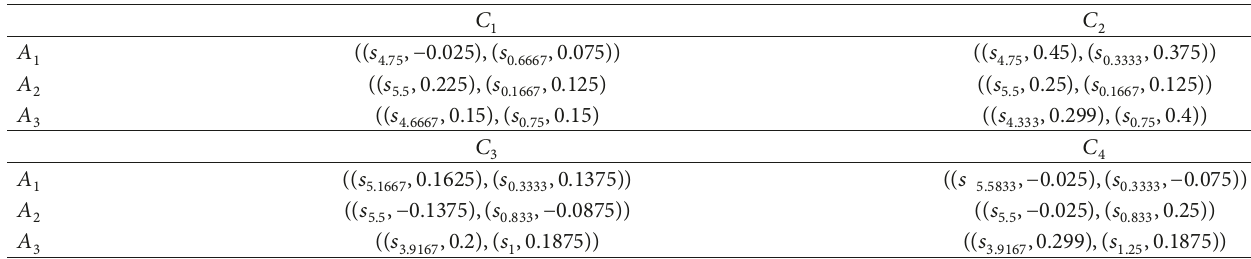
Table 8: The aggregated matrix